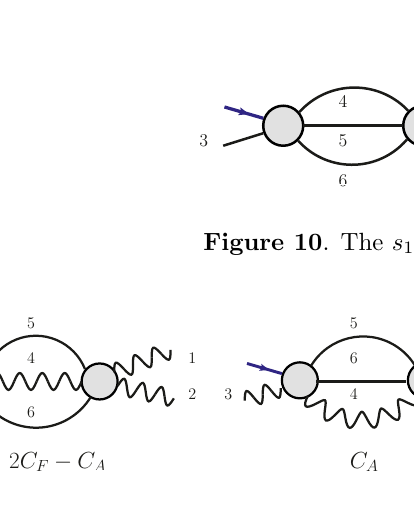
Figure 11 . Di(cid:11)erent ordering of (cid:12)elds corresponds to di(cid:11)erent color